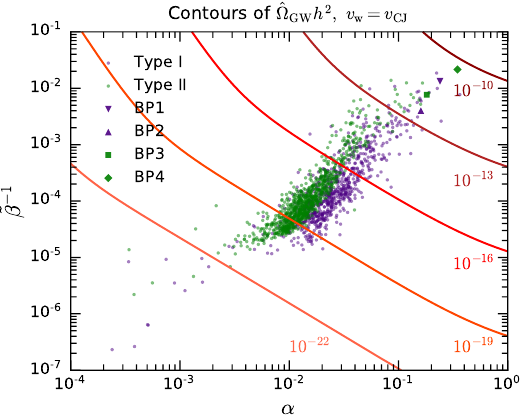
Figure 3 . Contours of the peak amplitudes of the GW spectra in the α - ˜ β − 1 plane assuming Jouguet detonations. Purple and green points denote the parameter points for type-I and type-II Yukawa couplings, respectively. Four BPs are also